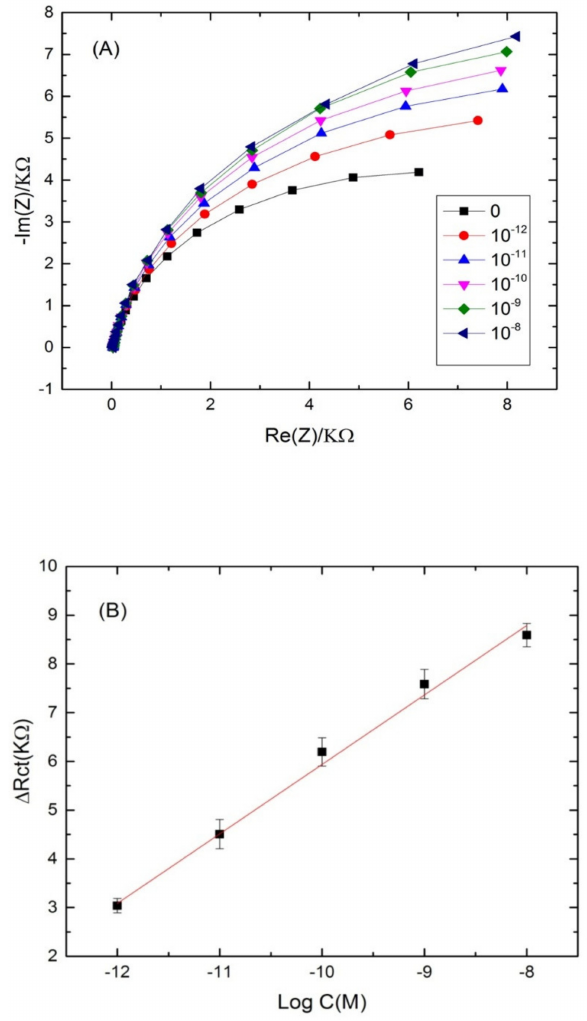
Figure 6. ( A ) Nyquist plots of Cd-aptamer-modified surface incubated with increasing concentrations of real samples spiked with cadmium. Measurements were performed at a potential of − 0.5 V and a frequency range from 10 kHz to 100 mHz. ( B ) Calibration plots of the increase of the charge transfer resistance with cadmium concentration in real water samples for the label free